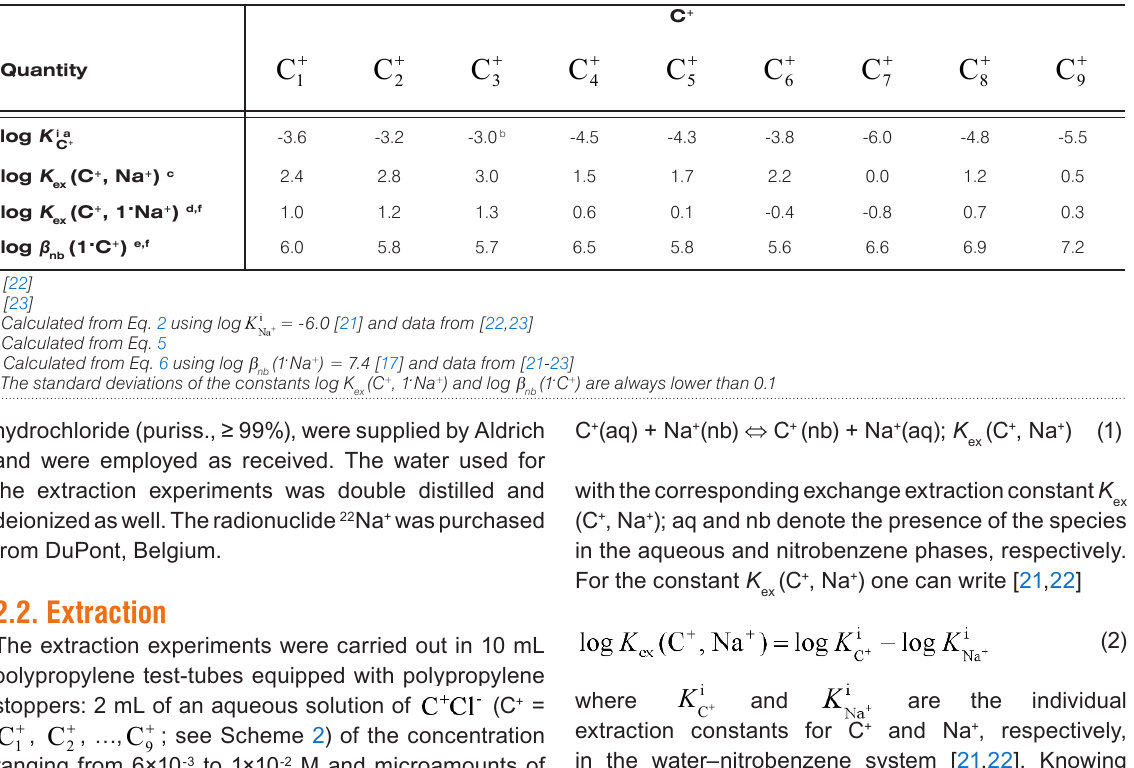
Table 1. Equilibrium data for the C + and 1. C + cations in the two-phase water-nitrobenzene extraction system at 25 °C (C + = + 1 = benzo-18-crown-6; for the meaning of the constants see text).